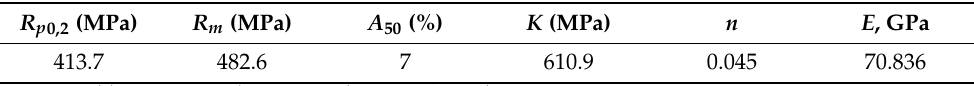
Table 1. Basic mechanical properties of 7075-T6 aluminium alloy *. R p 0,2